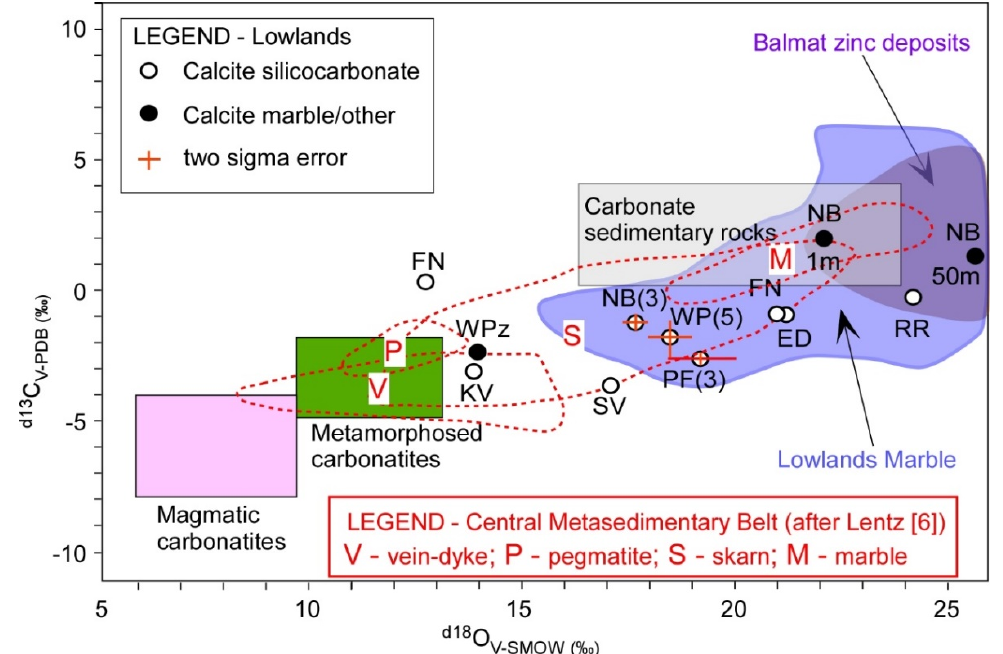
Figure 7. Carbon and Oxygen isotopic ratios and two sigma error bars for calcite from silicocarbonates in this study. See text for more details. Fields for magmatic carbonatites [32], for Lowlands marbles [30], for Balmat zinc deposits [31], for Natural Bridge analyses [20], and for metamorphosed carbonatites of the Central Metasedimentary Belt [3]. Fields in dashed red are from the Central Metasedimentary Belt of Ontario (Lentz [6]). Parentheses indicate the number of analyses; those without error bars were analyzed once. WPz refers to calcite associated with the zinc deposits at West Pierrepont, NY.